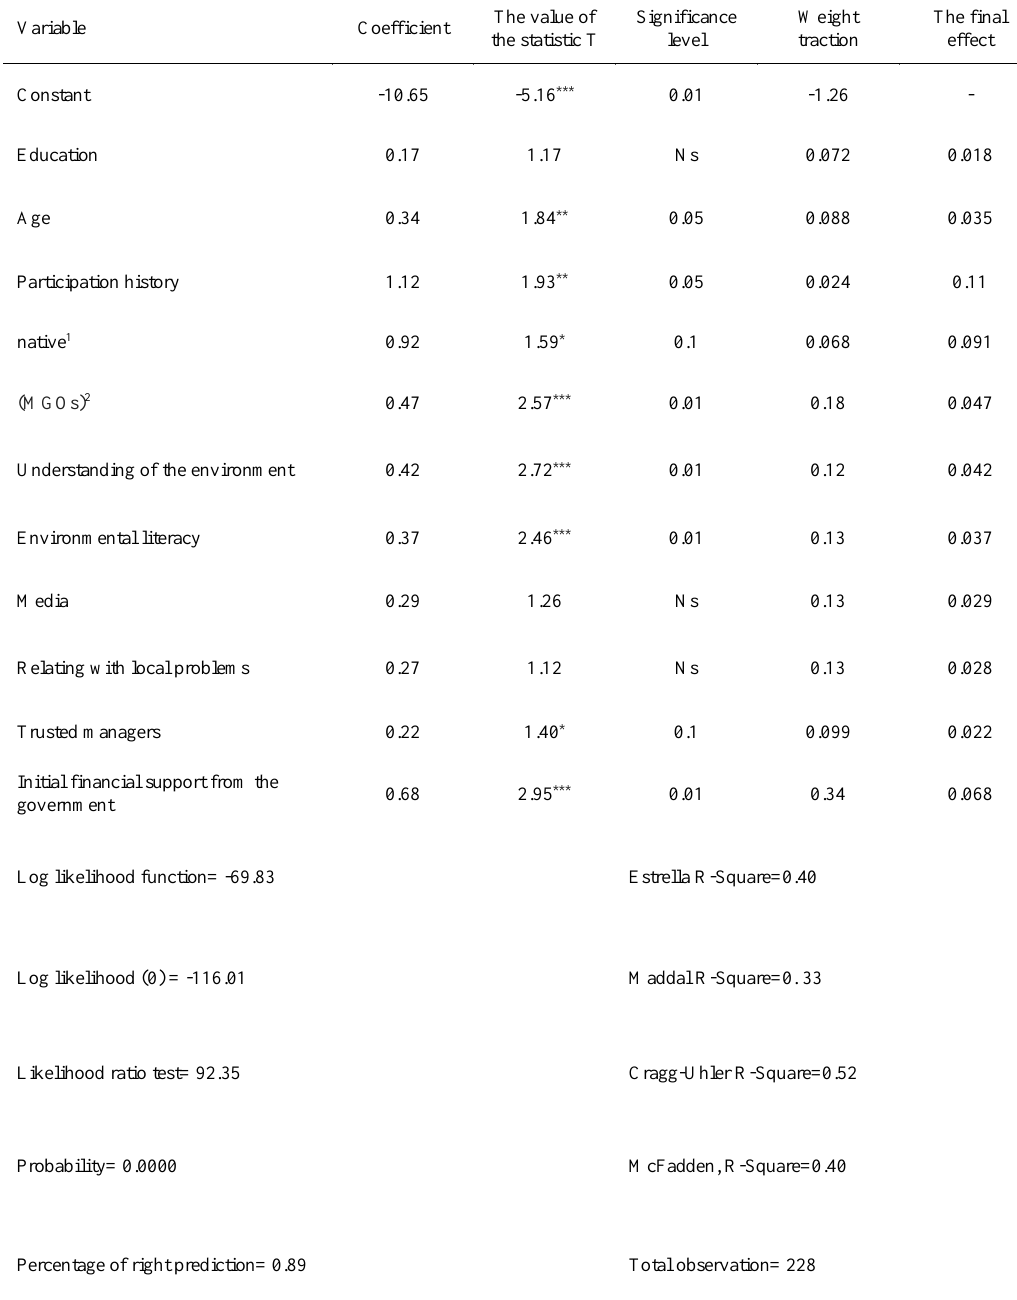
Table 2: The result of Logit model